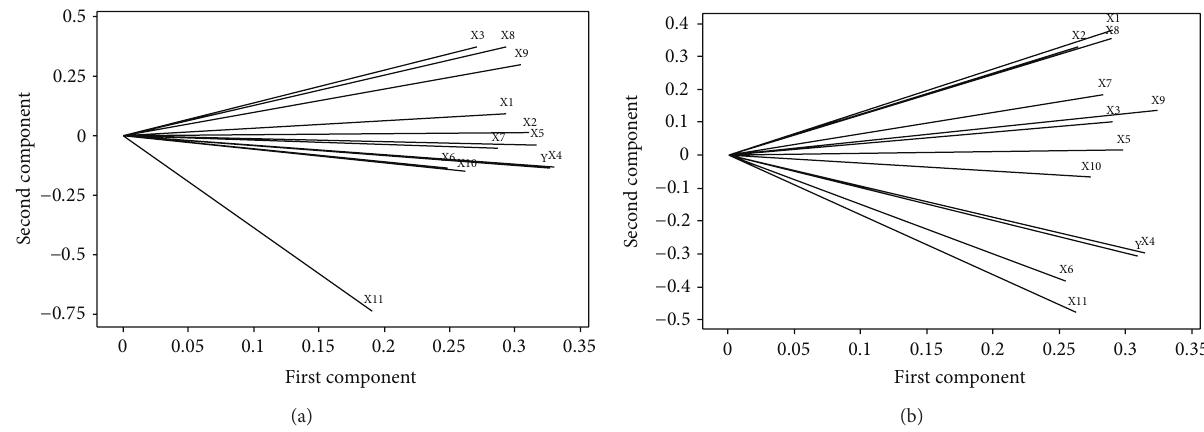
Figure 3: (a) Variables loading by principal component analysis with first two components under inoculation condition and different water levels. X1: tiller numbers/plant, X2: spike length, X3: spikelets/spike, X4: spike weight/plant, X5: grain number/spike, X6: grain weight/spike,